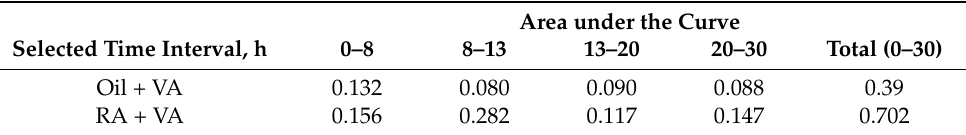
Figure 2. Fraction of ingested dose (FD) in the intestine vs. time after administration of 3 H-labeled VA supplement in neonatal rats: ( A ) During the first absorptive phase; ( B ) Over the entire study. Data are presented as means ± SEM, n = 4–6 pups/time/group. * indicates statistically significant difference between groups, p < 0.05. Table 2. Area under the curve indicated higher intestinal 3 H-labeled VA accumulation in RA-pretreated pups at later hours after VA supplementation. Area under the Curve Selected Time Interval, h